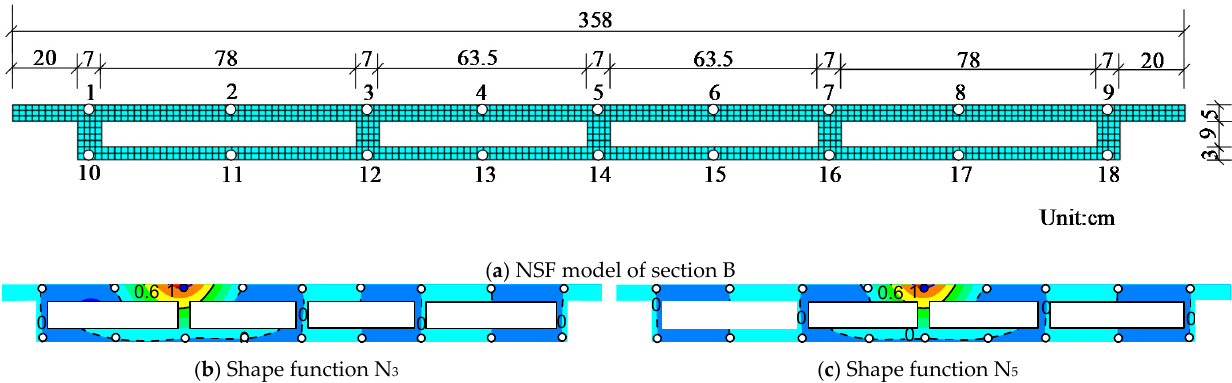
Figure 1. NSF model and contour map of the numerical shape function: ( a ) NSF model of section B; ( b ) shape function N 3 ; ( c ) shape function N 5 .